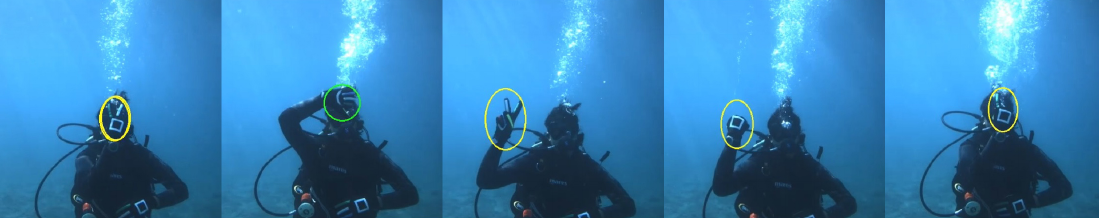
Figure 8. “Go down 2 m” gesture sequence executed during